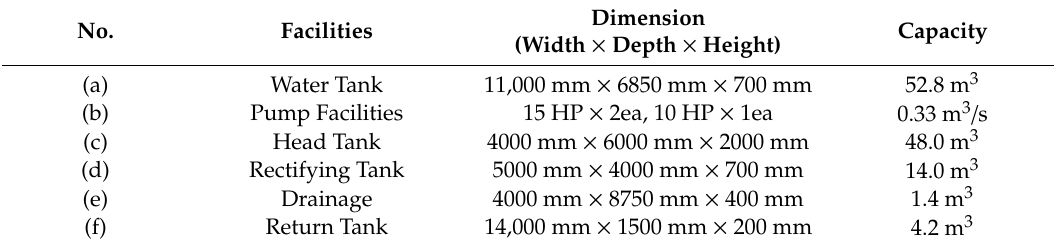
Table 4. Specifications for hydraulic